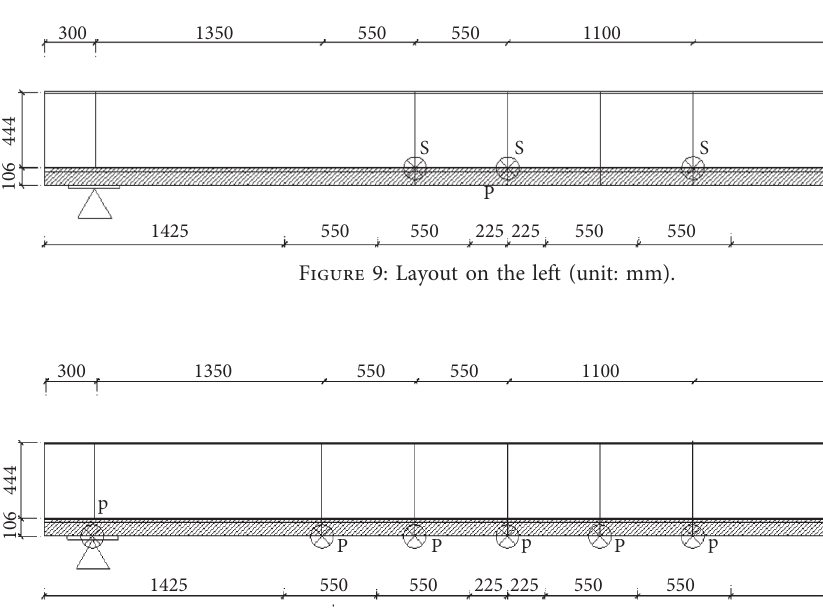
Figure 10: Layout on the right (unit: mm).